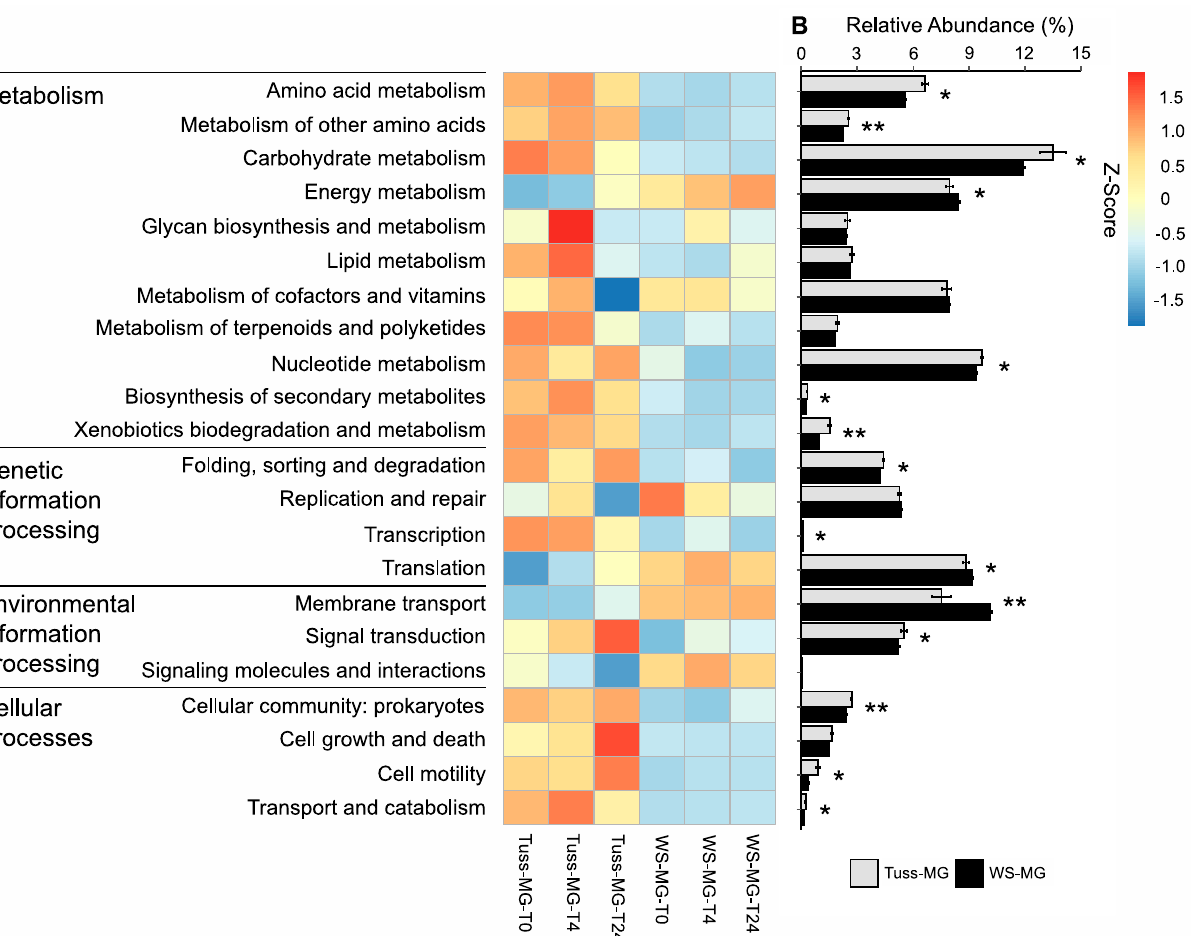
Figure 2. Heatmap ( A ) and barplot ( B ) of genomic potential based on the mean relative abundance of GPM-normalized metagenome (MG) genes belonging to KEGG tier III functional pathways by sampling time point in mesocosm replicates of tussock tundra and wet sedge tundra communities. Z-score transformations based on the mean relative abundance of genes between sampling time points for each KEGG pathway. Error bars for each barplot represent standard deviation from the mean. Asterisks mark the significance of differences in mean relative gene abundance between tundra communities for each KEGG tier III pathway (paired t-test; ** p < 0.01; * p < 0.05).